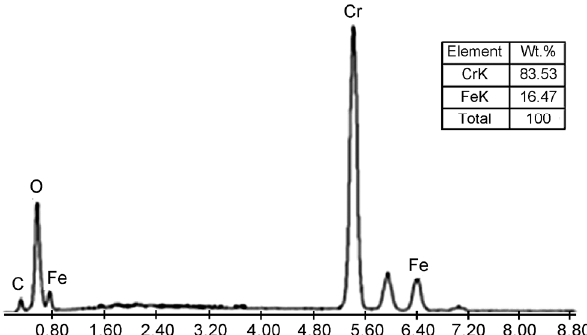
Fig. 8 EDS spectrum of the ring surface after the